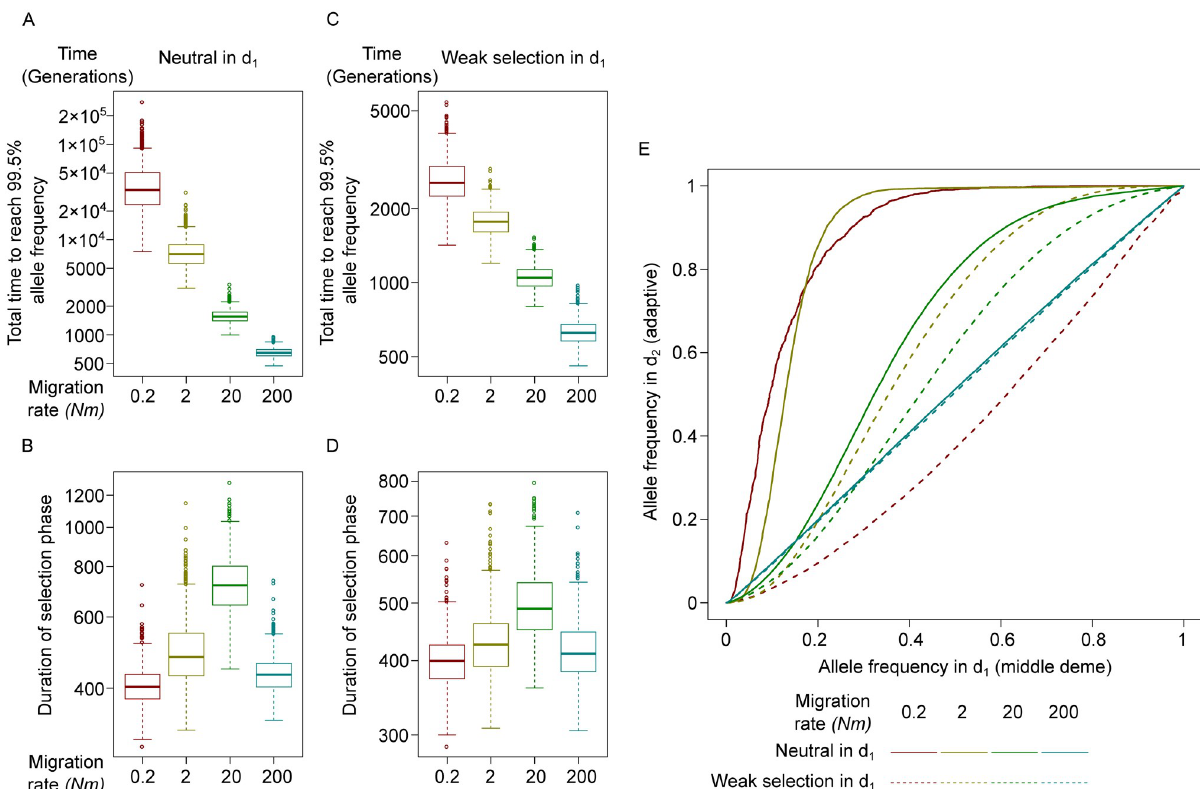
Fig 3. Single-site simulation: Through a middle-deme. A, C: The time taken for an adaptive allele from the initial mutation event to reach a frequency of 99.5% in the destination deme d 2 . B, D: The duration of selection phase, defined as the time between the adaptive allele reaching 5% and 99.5%, in the destination deme d 2 . The allele has no fitness effect (A, B), or a very weak one (C, D) in the middle deme d 1 . E: The average joint trajectory of the adaptive allele frequency in d 1 and d 2 , where the allele is neutral (solid lines) or very weakly selected ( s = 0.005, dash lines) in d 1 . In the left-top half, the frequency is lower in d 1 . Different colors indicate different migration